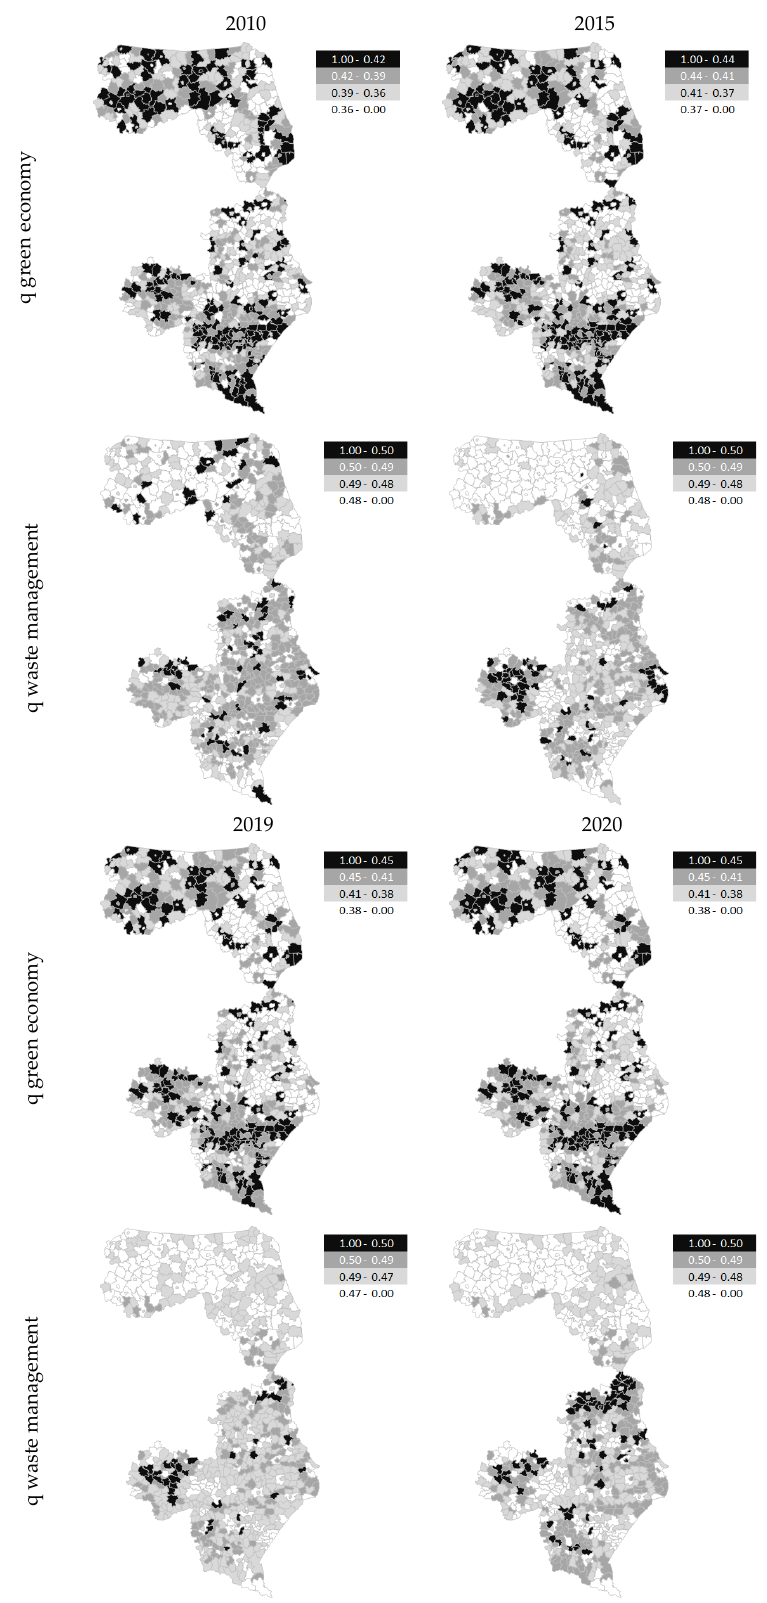
Figure 4. The range of the synthetic measure, waste management and green economy in communes of Eastern Poland in 2010–2020. Source: own study. Figure 5 shows the classification due to the synthetic measure -green economy and waste management. The back color marked a group of municipalities characterized by a better situation in the studied area (higher value of the synthetic measure). Lighter color indicates weaker units (lower value of the synthetic measure).